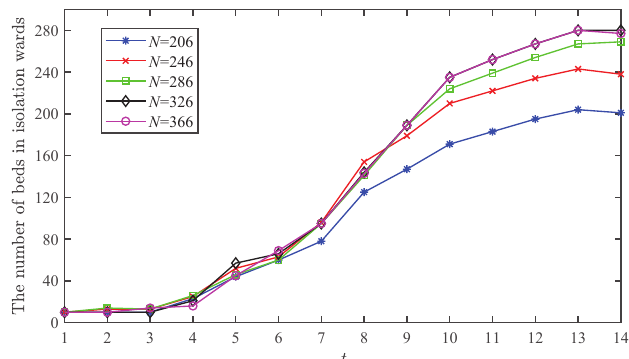
Figure 6. The number of beds in isolation wards in case